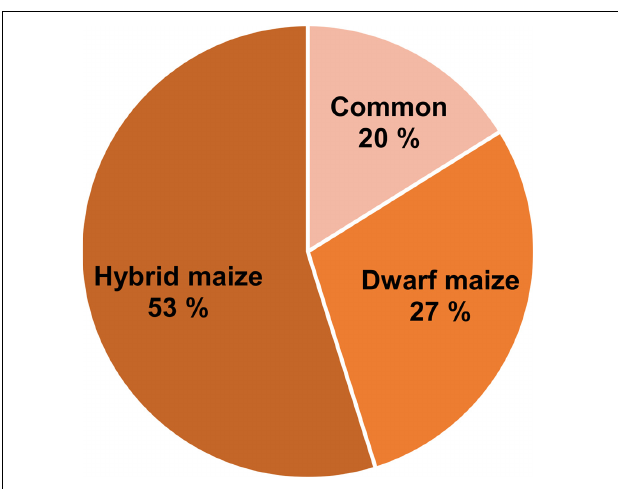
FIGURE 3 | Pie chart representing the percentage of common and specific infection biomarkers to hybrid and dwarf maize. The numbers take into account identified, tentatively identified, and unidentified